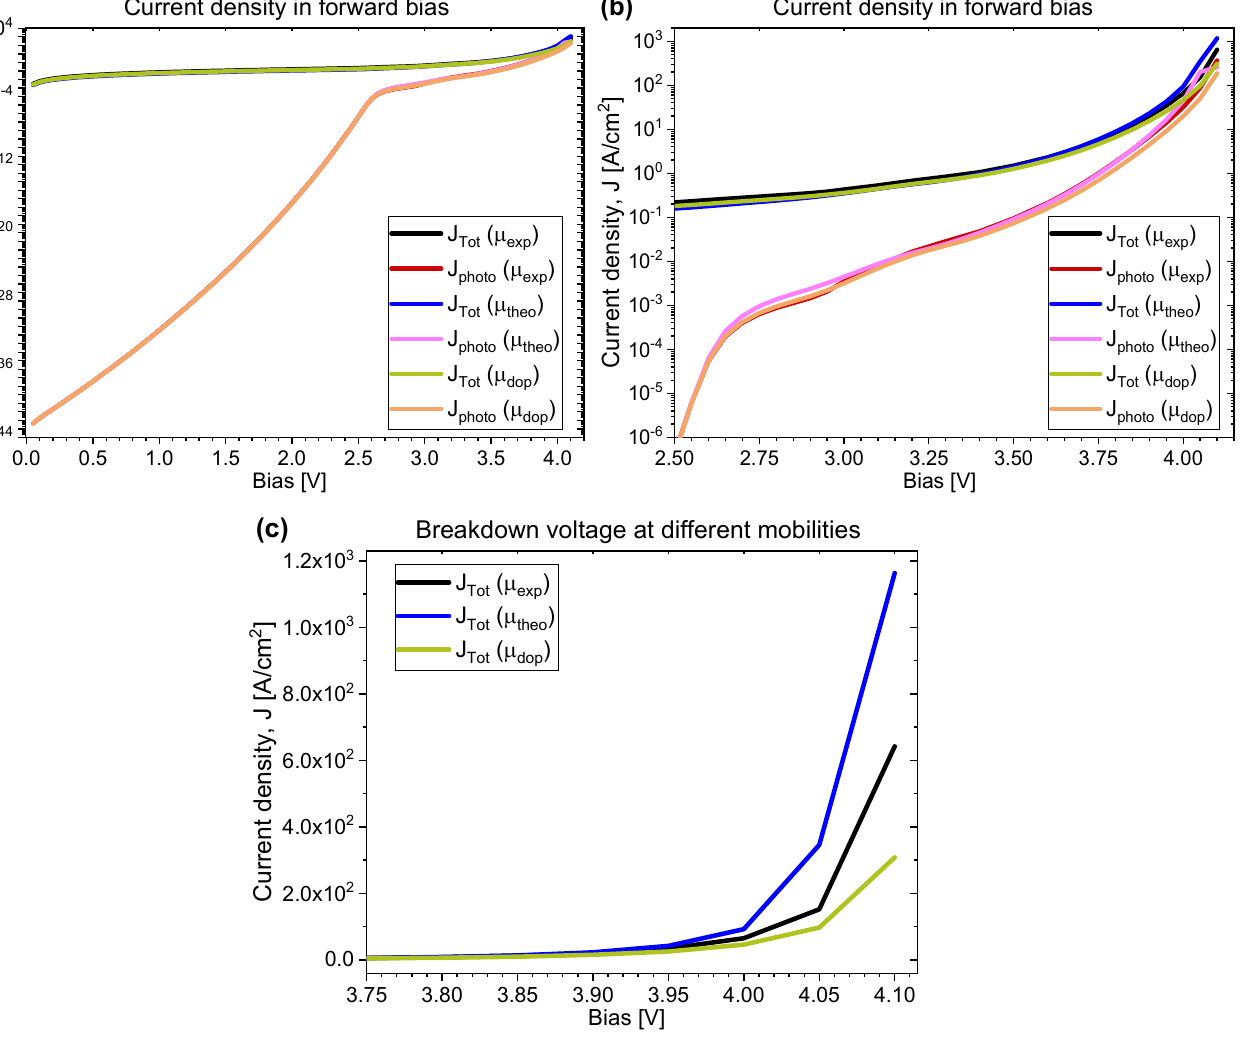
Figure 4. (J−V) curves in forward bias: ( a ) from [0−4] V in logarithmic scale, ( b ) the magnification between [2.5–4.1] V in logarithmic scale, and ( c ) breakdown voltage of the simulated LED. Analysis of the physical parameters of the LED was performed for four different voltages points (2.5 V, 3.0 V, 3.5 V, 4.0 V) where the photocurrent rises. Figure 5 corresponds to the spatial distribution current and density carrier results inside the active layer from the device at 2.5 V. In Figure 5a, hole and electron density currents are not reduced in quantum wells. Here, it can be seen that the hole current density for experimental, theoretical, and doping-concentration simulations have a magnitude of almost zero ( J h = − ( 3.5 − 5.3 ) × 10 − 4 A/cm 2 ). However, the electron current density presents significant differences. In ascending order the values are: J e − theo = − ( 1574.84 ± 0.07 ) × 10 − 4 A/cm 2